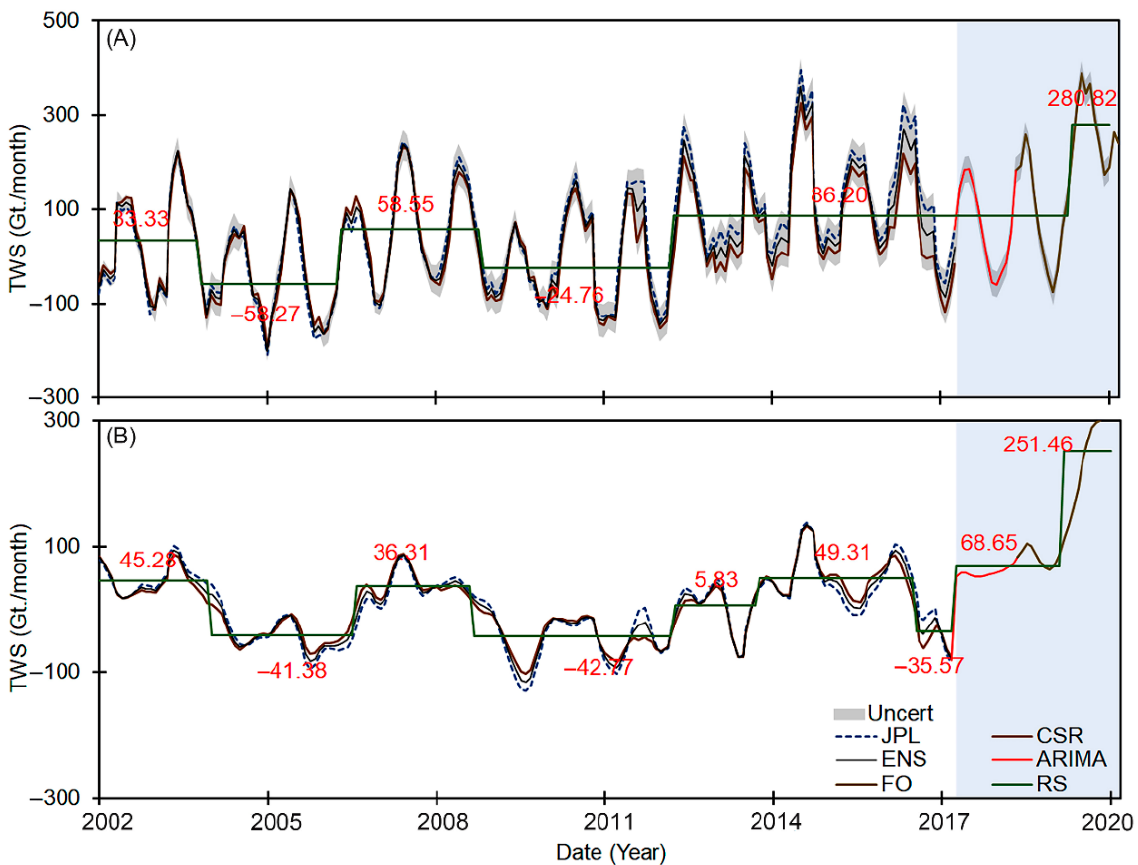
Figure 3. TWSA ( A ) and the cycle trend component ( B ) over the NRB using Center for Space Research (CSR), Jet Propulsion Laboratory in California (JPL), and Ensemble (ENS) mascons solutions between 2002–2017, the red lines represent the gap-filling between 2017–2018, the shaded area represents the GRACE-FO (Follow-On) TWSA estimates between 2018–2020. The graph indicates the significant regime shift (RS) in the mean (green line).